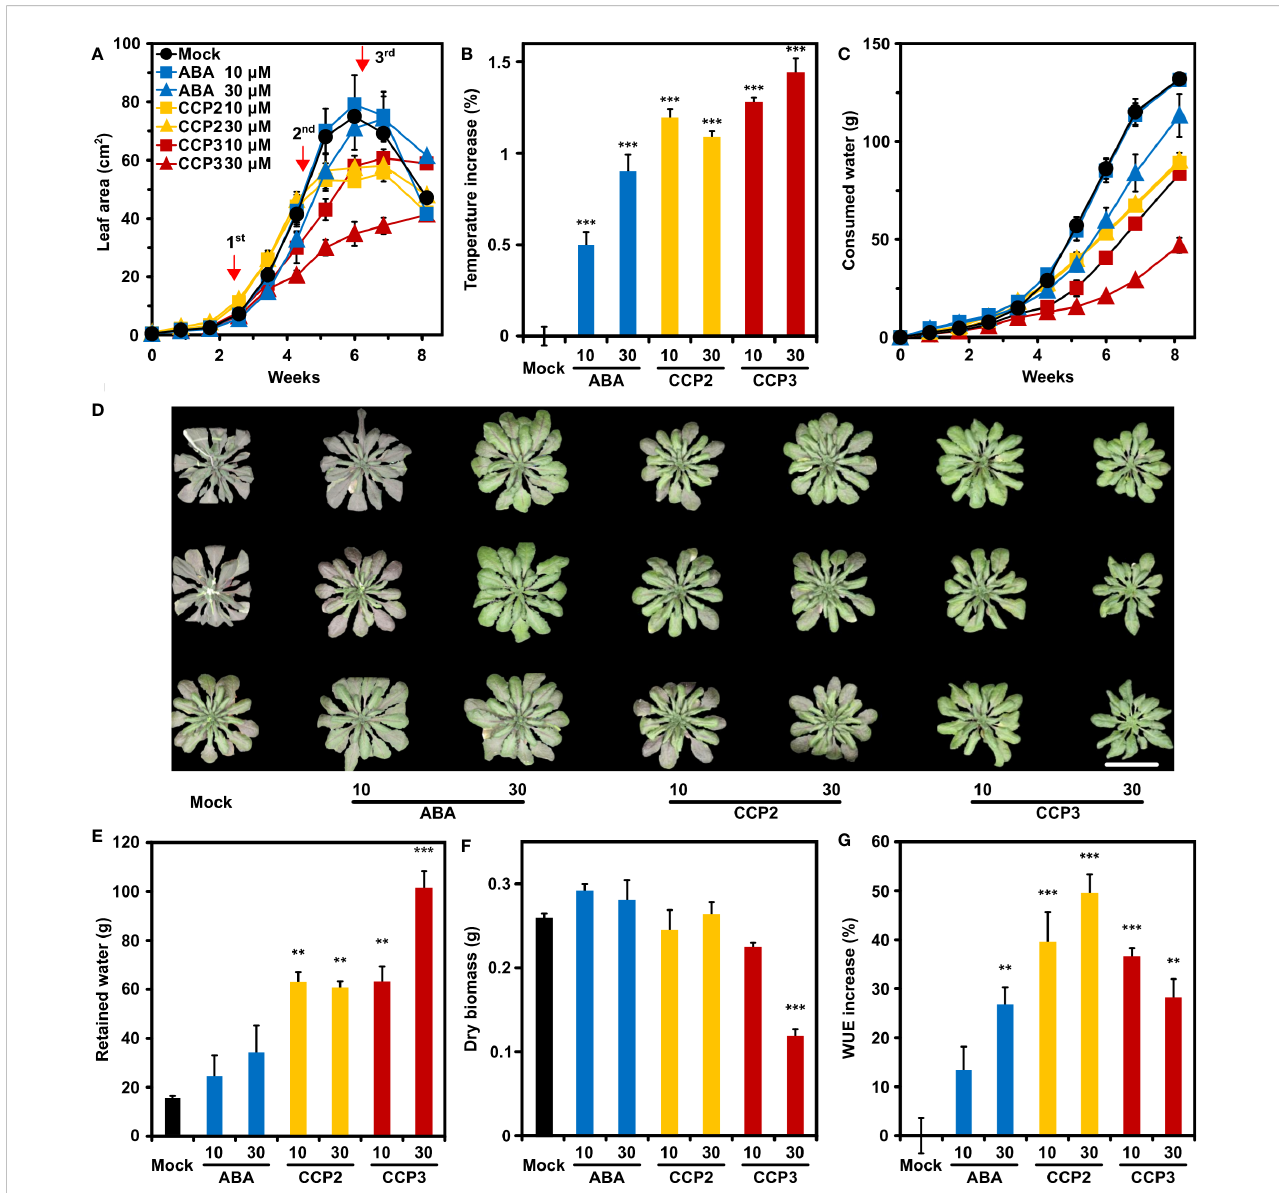
FIGURE 6 CCP2 and CCP3 are more ef fi cient than ABA in enhancing WUE in Arabidopsis. (A) Kinetics of leaf growth of mock-treated plants (black), plants exposed to ABA (blue), CCP2 (yellow), or CCP3 (red) during a progressive drought experiment. The ligand solution of 10 µM (squares) and 30 µM (triangles) were administrated on day 18, 32, and 43 indicated by red arrows. The drought experiment started with cease of watering of 18-day-old plants. Growth of the plants is expressed as an increase in the projected leaf area. The decrease in leaf area was caused by leaf wilting. Statistical signi fi cance of leaf area is shown in Supplementary Table 9. (B) Leaf temperature increase of ABA- and CCPs-treated plants compared to mock-treated plants (22.5 ± 0.05°C) 24 h after the fi rst administration. (C) Time course of total water consumption during the progressive drought experiment. (D) Wilted mock-treated plants and turgescent ligand-treated leaf rosettes at day 48. All potted plants were randomized and three representative plants for each treatment were rearranged as shown after imaging. The scale bar indicates 5 cm. At the end of the experiment at day 57, (E) the residual amount of soil water, (F) above-ground dry matter, and (G) the increase in WUE compared to mock-treated plants (WUE = 2.0 g L -1 ± 0.1 g L -1 ) was determined. The growth conditions are described in Figure 5, n = 4 biological replicates per treatment, mean ± SEM, **P < 0.01, ***P < 0.001 (one-way ANOVA) compared to